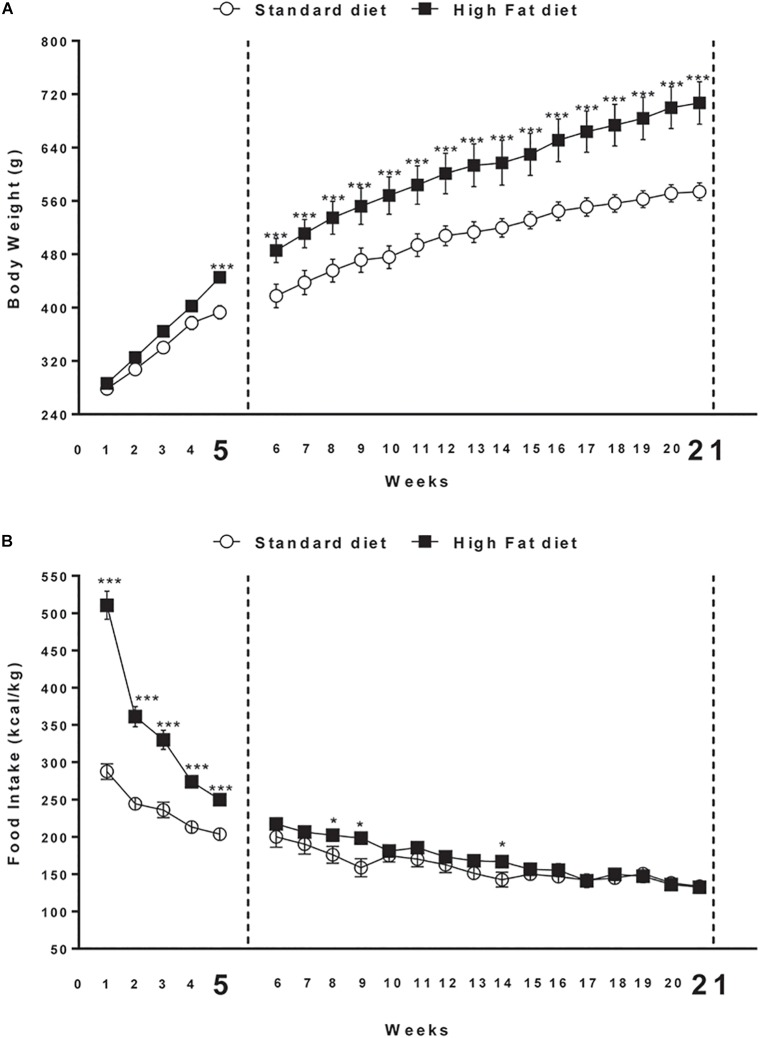
(A) Body weight and (B) cumulative food intake (kcal) measured weekly in rats exposed for 5 and 21 weeks to high fat (HFD) or standard diet (STD). Significant differences are indicated: ∗∗∗P < 0.001, ∗P < 0.05 vs. STD.